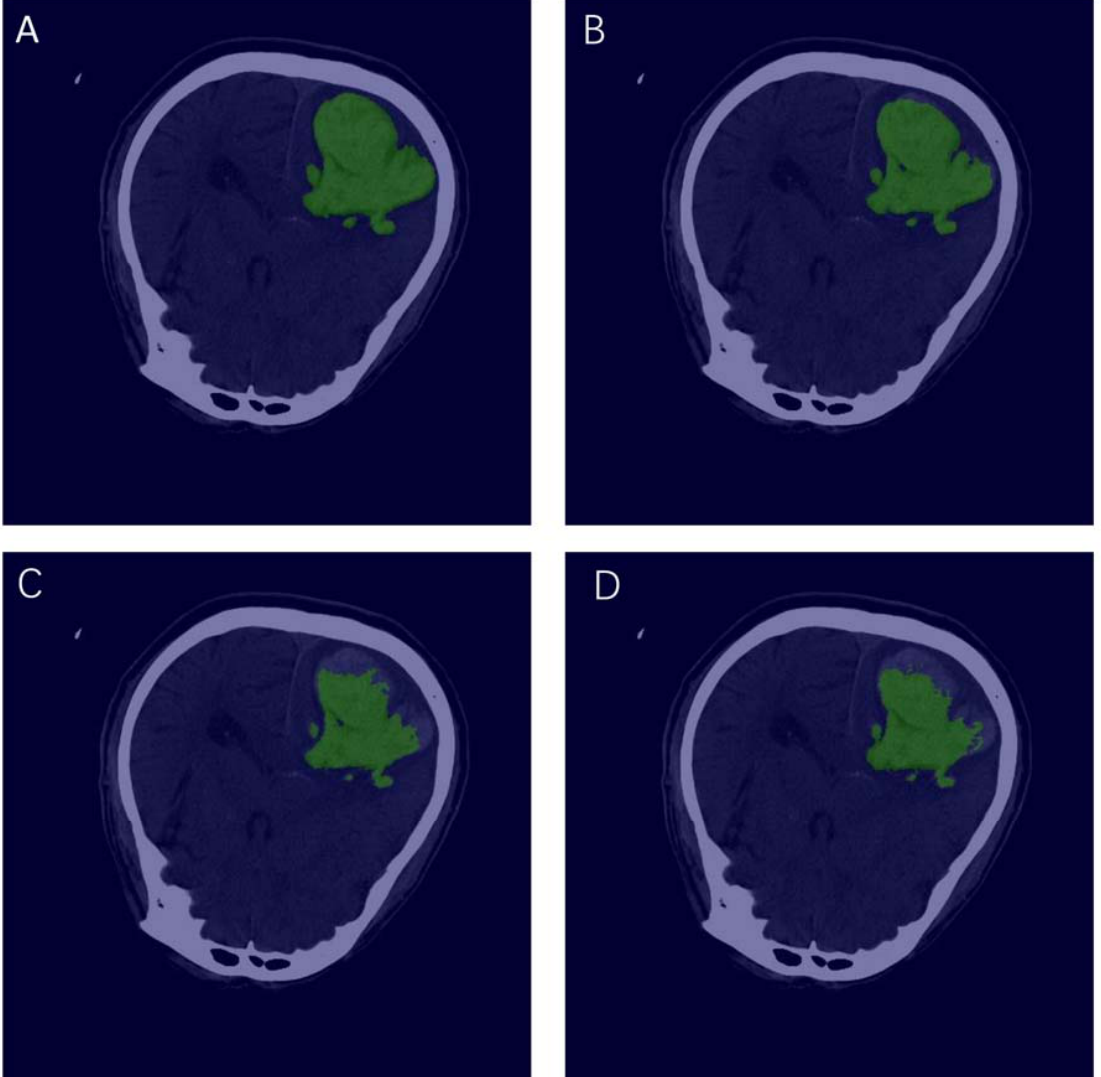
Figure 3. Visualization of manual labeling and each segmentation model. where ( A ) represents a manually labeled slice; ( B – D ) represent the result of the automatic segmentation of U-Net with attention, U-Net++, and U-Net, respectively. Table 2. Comparison of model segmentation results.